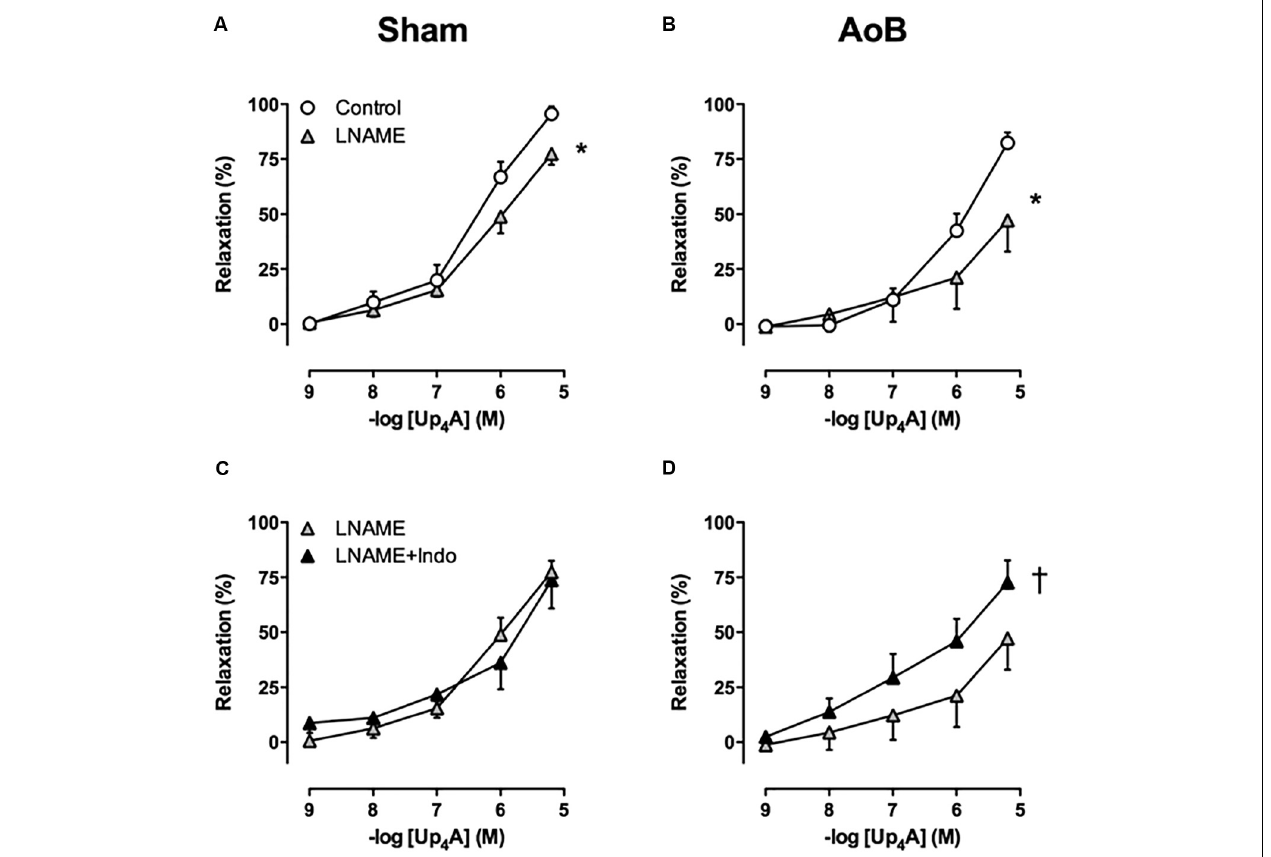
FIGURE 7 | eNOS inhibition with LNAME attenuated the response to Up 4 A to a similar extent in coronary small arteries from Sham-operated swine ( A , n = 8) and swine with AoB ( B , n = 7). Subsequent inhibition of cyclooxygenase with indomethacin (Indo) had no effect in vessels from Sham ( C , n = 7), but enhanced relaxation to Up 4 A in vessels from swine with AoB ( D , n = 6). Control data are the same as in Figure 2 (‘Sham’ and ‘AoB’). ∗ P < 0.05 effect of LNAME vs. corresponding control; † P < 0.05 effect of LNAME + indomethacin vs. LNAME alone.